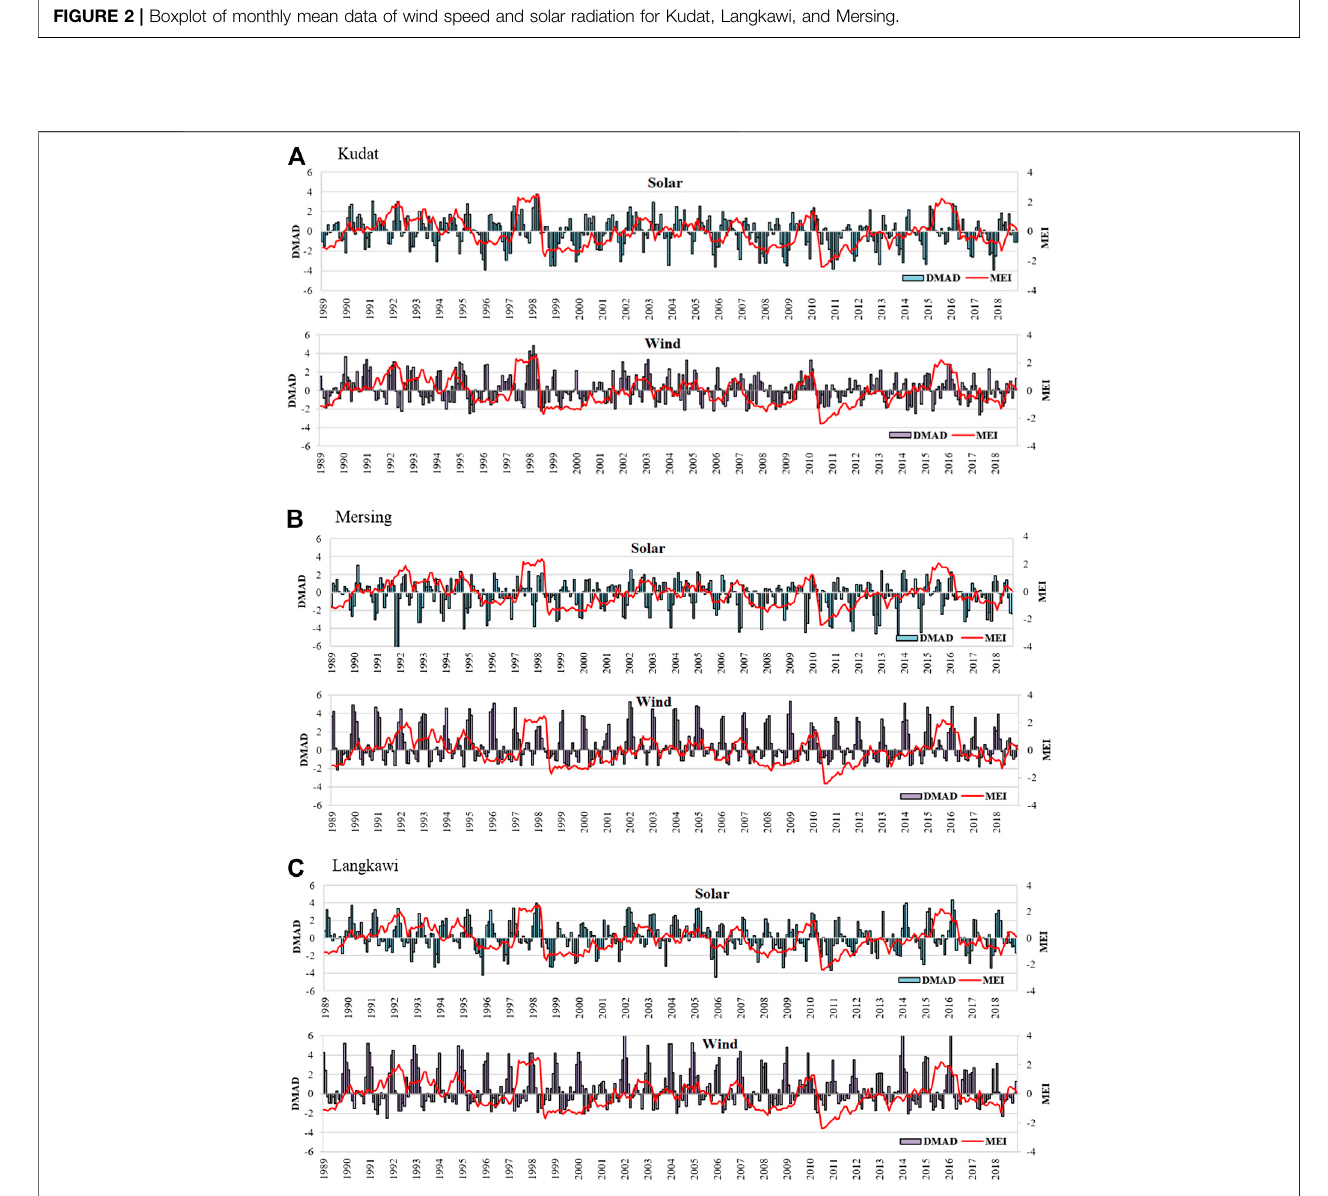
FIGURE 3 | The dimensionless median absolute deviation (DMAD) of ERA5 wind/solar data and the multivariate ENSO index (MEI).